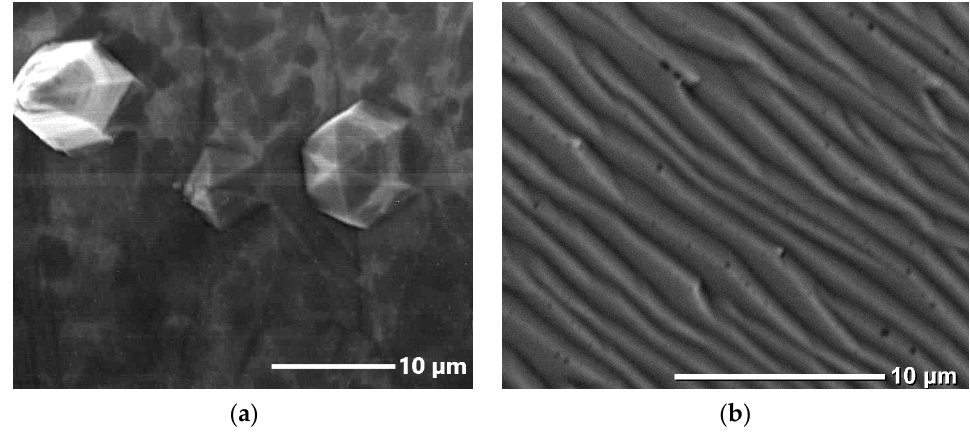
Figure 1. SEM images of ZnO samples’ surface: ( a ) Hybrid sample; ( b ) control sample.